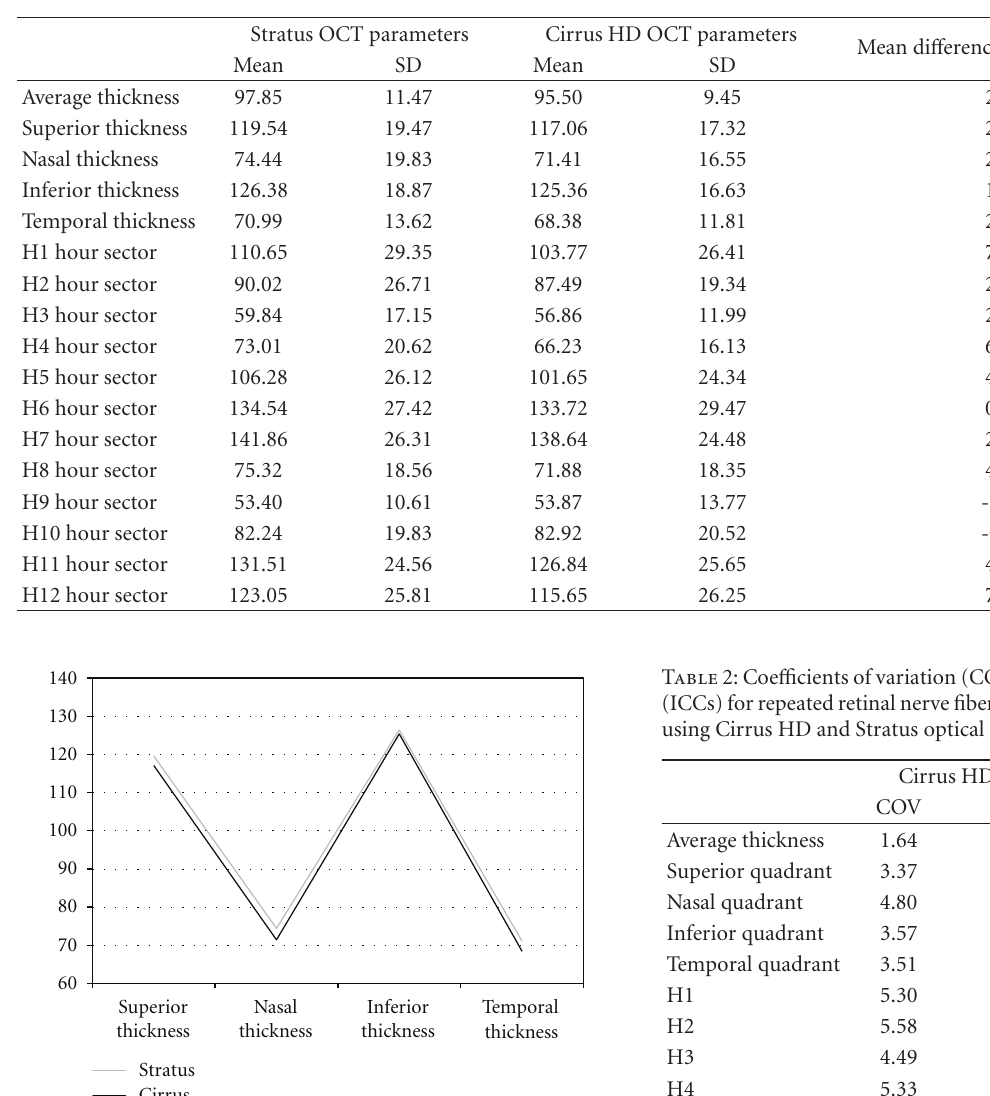
Table 1: Mean retinal nerve fiber layer parameters and standard deviation measured by Cirrus high definition (HD) and Stratus optical coherence tomography (OCT) and their statistical comparisons.